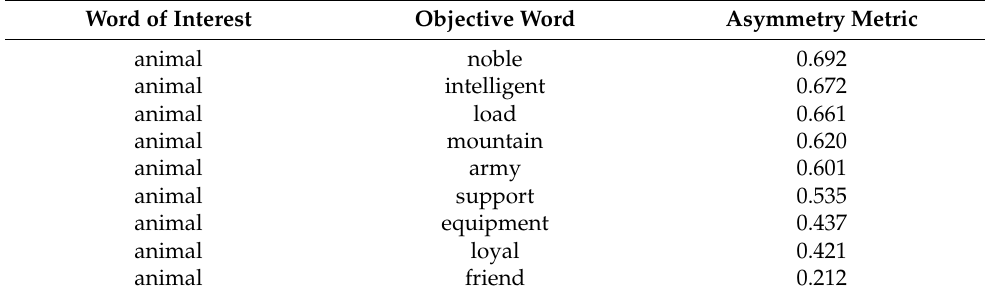
Table 9. Results of the latent semantic analysis in terms of word of interest and objective word and their respective asymmetry metric for the question What do mules represent or mean for